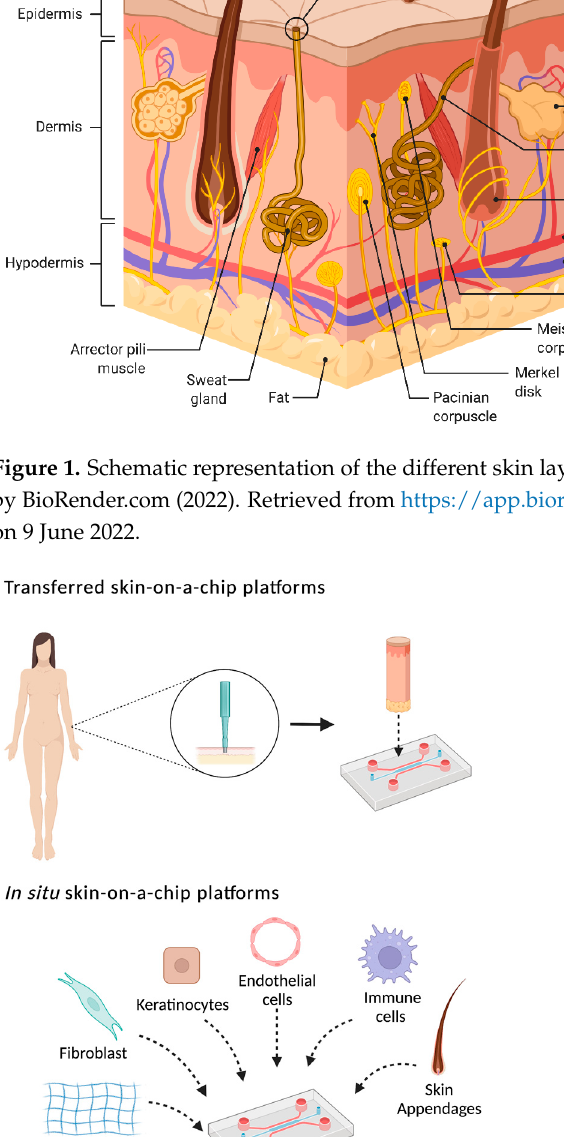
Figure 1. Schematic representation of the different skin layers. Adapted from ‘Anatomy of the skin’, by BioRender.com (2022). Retrieved from https://app.biorender.com/biorender-templates, accessed on 9 June 2022.